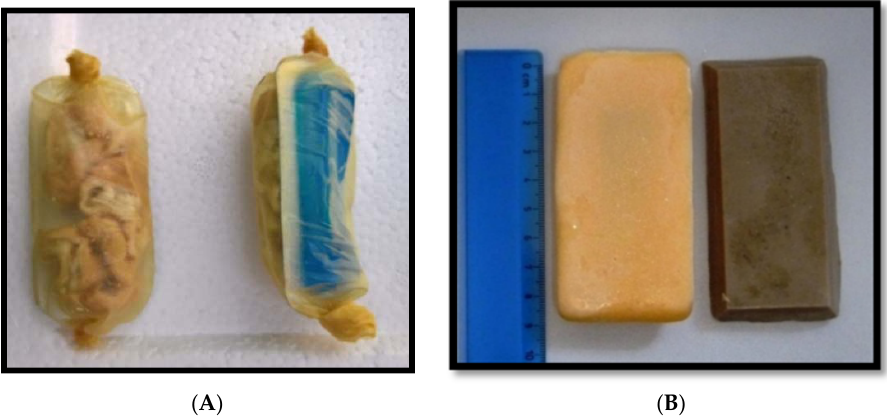
Figure 1. The intestine bait with ( A ) and experimental egg-flavored bait (yellow) and fishmeal bait (brown) ( B ). All bait types contained a vaccine capsule filled with dyed water as can be seen in the intestine bait.